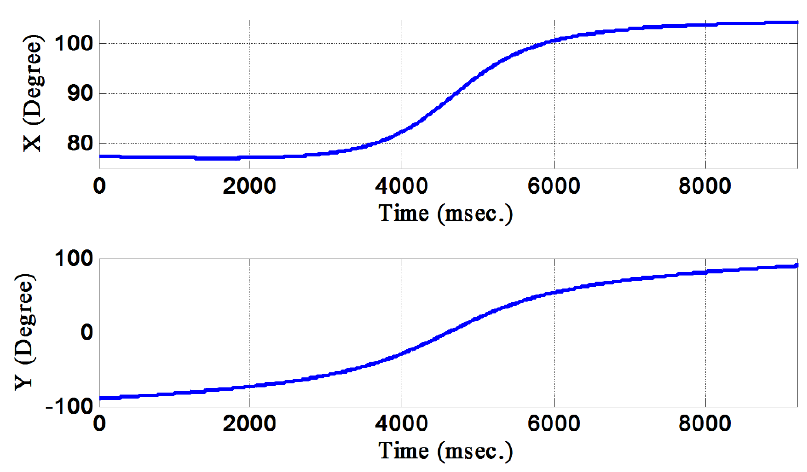
Figure 3. Satellite trajectory in terms of 𝜃 1 and 𝜃 2 as the reference inputs.